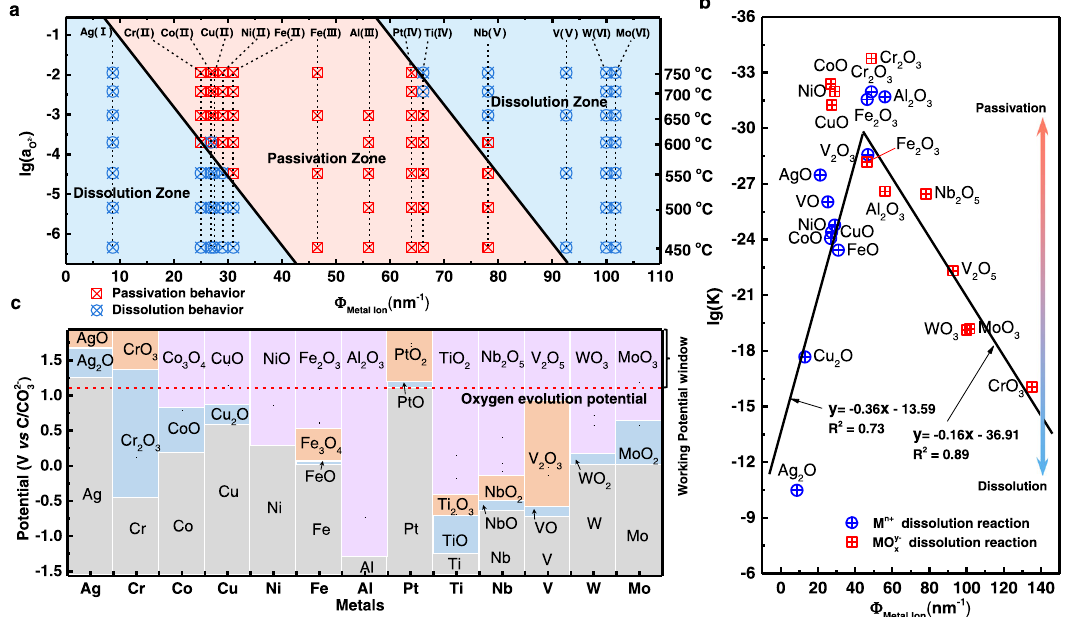
Fig. 1 | Criteria for the selection of oxides for HT-OER electrodes. a Anodic oxi- dationbehaviorsoftypicalmetals(Ag,Cr,Co,Cu,Ni,Fe,Al,Pt,Ti,Nb,V,W,andMo)as a function of their corresponding ionic potentials ( Ф Metal Ion ) in molten Li 2 CO 3 – Na 2 CO 3 – K 2 CO 3 with different lg(a O 2 (cid:2) ) , the region can be divided